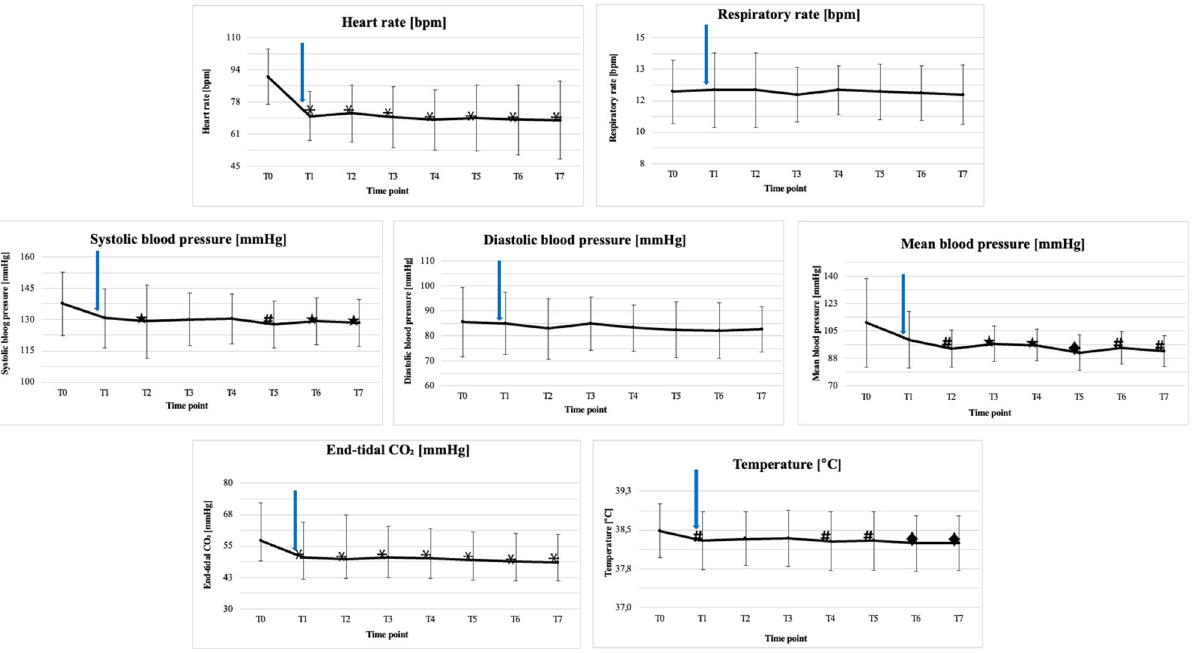
Figure 2. Graph of the mean values of the measurements (HR, RR, SYS, DIA, MEAN, et-CO 2 , T) at the respective time points. Statistically significant differences between T0 and the corresponding time point have been marked according to following rules: filled star for p ∈ (0.05, 0.01 >; number sign for p ∈ (0.01, 0.001 >; filled diamond for p ∈ (0.001, 0.0001 >; asterisk for p ∈ (0.0001, 0.00001 >; The blue arrow shows when stimulation